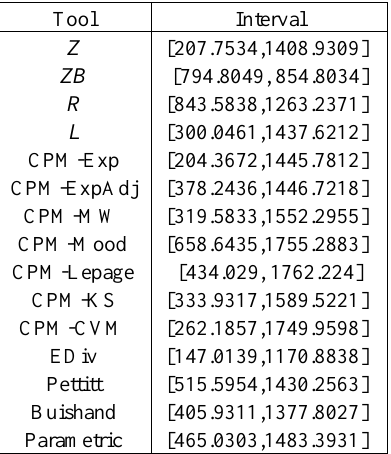
Table 4. 95% bootstrapped intervals from different change-point